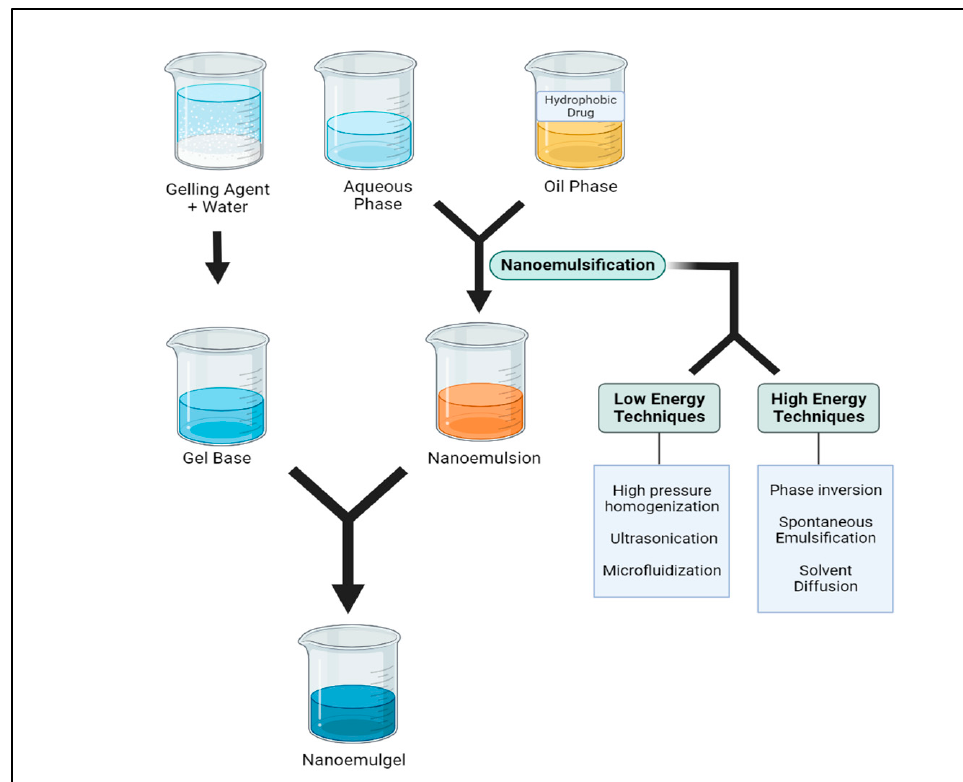
Figure 4. Steps to formulate the nanoemulgel. energy approaches include self-nanoemulsification and phase inversion (phase inversion temperature (PIT), phase inversion composition (PIC)), and the emulsification and solvent diffusion technique; meanwhile, high-energy techniques involve ultrasonication, microflu- idization and high-pressure homogenization. The use of low-energy procedures